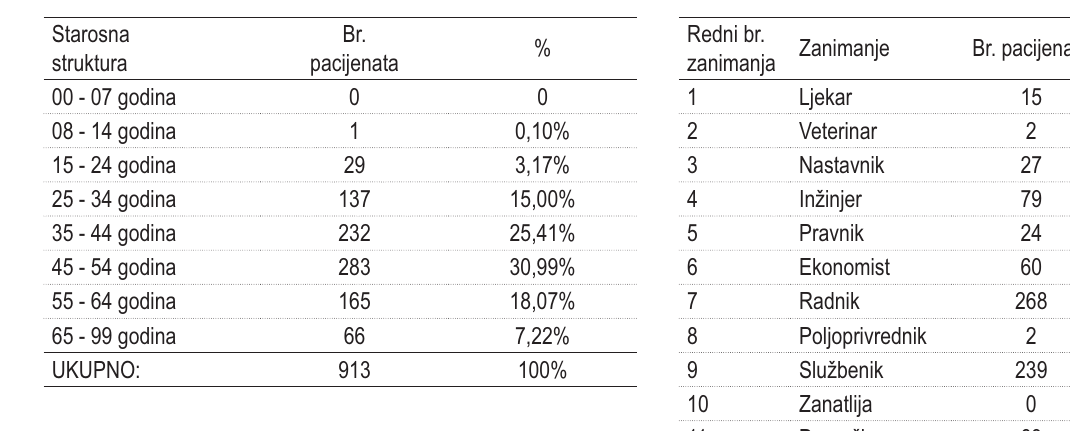
TABELA 2. Struktura pacijenata po dobnim